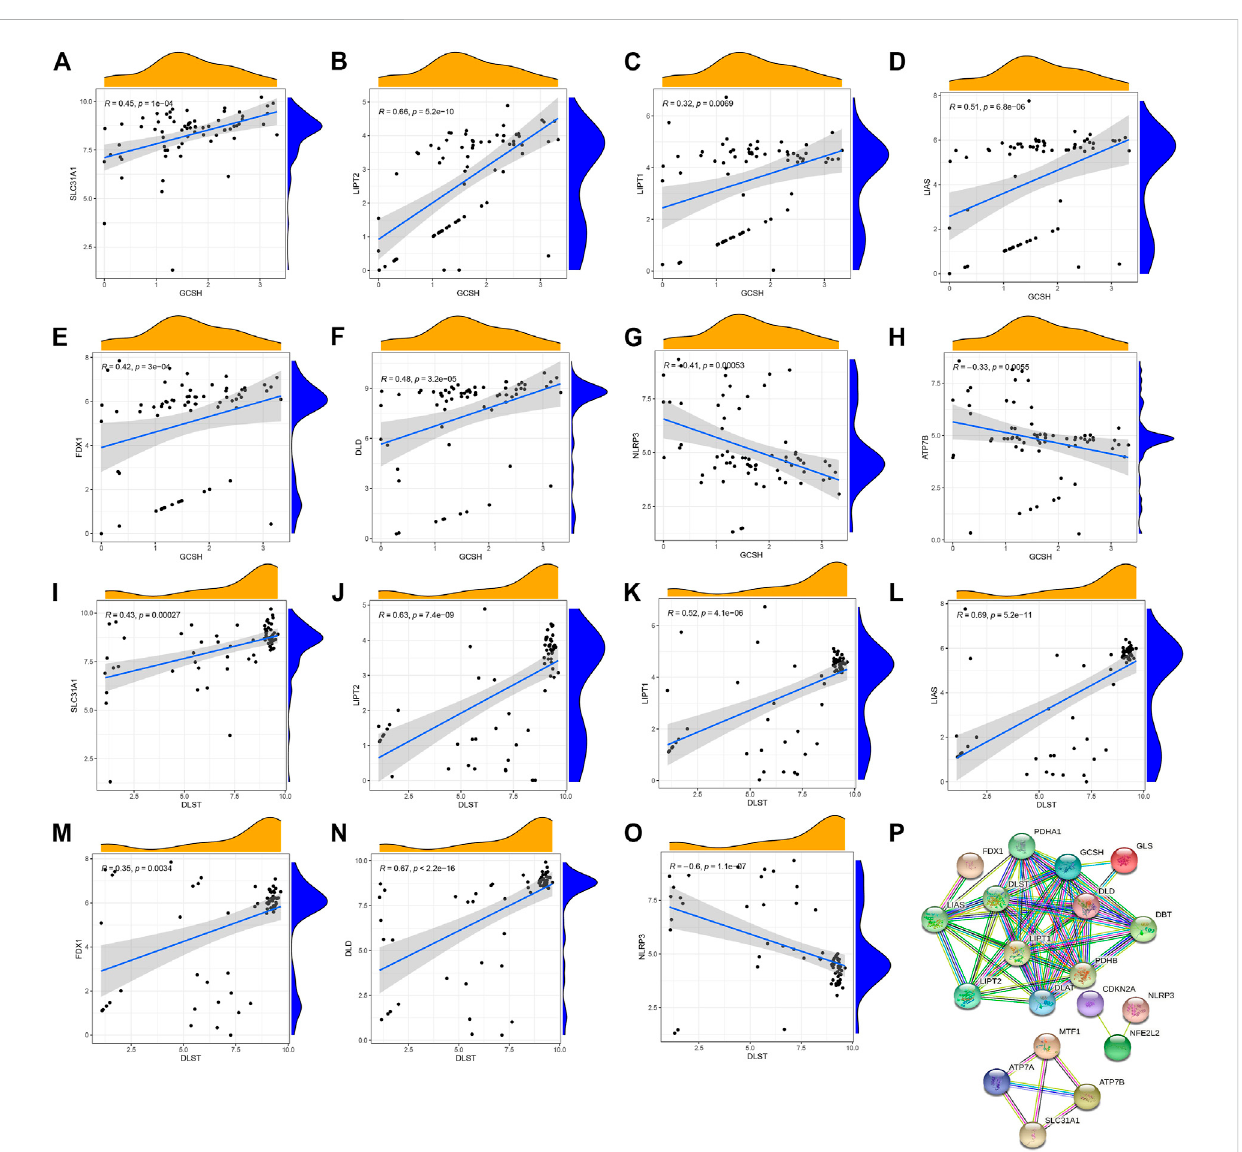
FIGURE 2 Correlation betweenwritersanderasersinpsoriasis. (A – F) TheexpressionlevelsofSLC31A1,LIPT2,LIPT1,LIAS,FDX1andDLDwerehighlypositively correlated with GCSH. (G,H) The expression levels of NLRP3 and ATP7B were negatively correlated with GCSH. (I – N) The expression levels of SLC31A1, LIPT2, LIPT1, LIAS, FDX1 and DLD were highly positively correlated with DLST. (O) NLRP3 expression level was negatively correlated with DLST. (P) The protein interactions of 19 cuproptosis-related